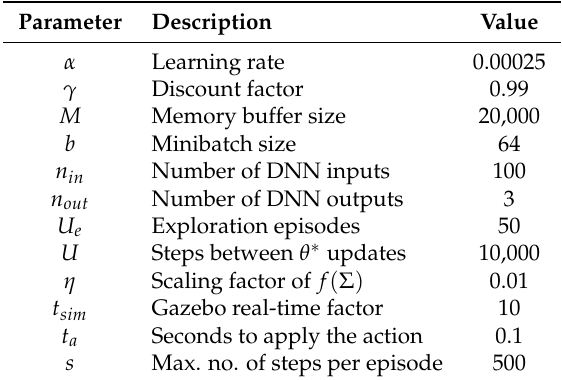
Table 2. Training and simulation main